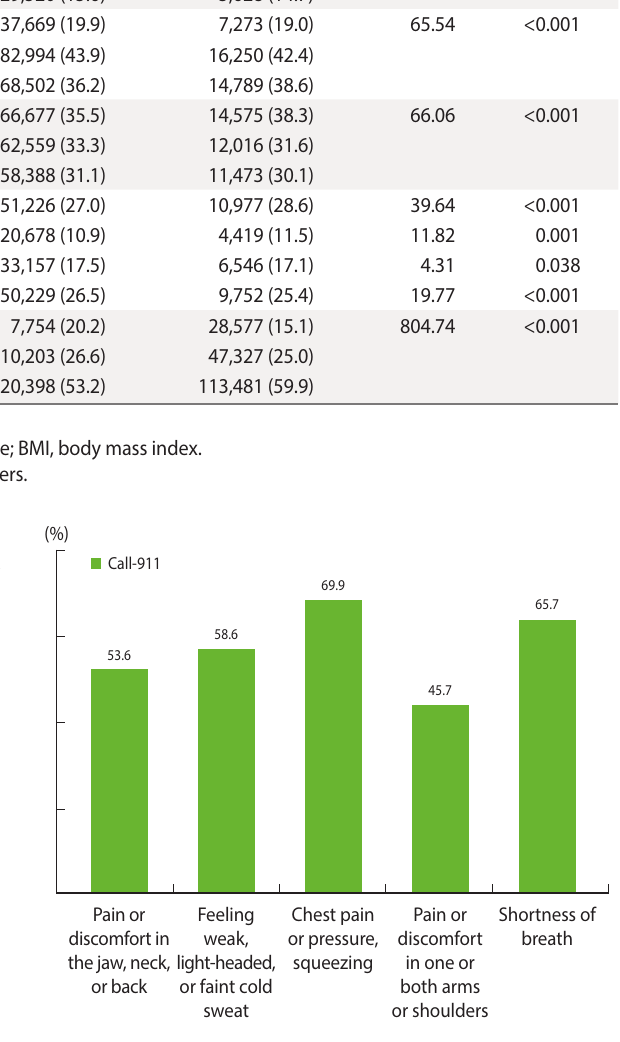
Figure 1. Comparison of correct anticipated coping behavior (call- 911) with each symptom of myocardial